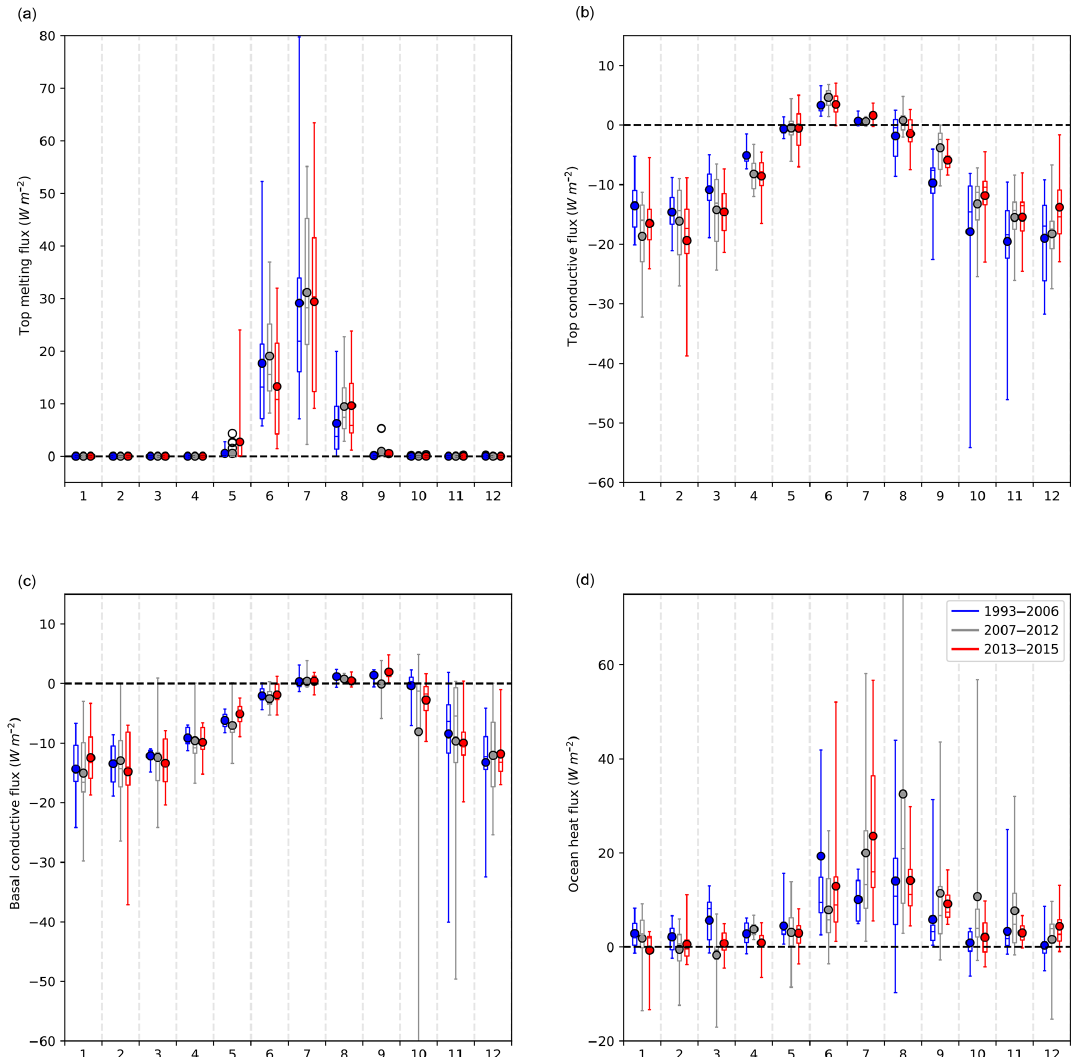
Figure 8. IMB-measured distributions of (a) top melting; (b) top conductive flux; (c) basal conductive flux, and (d) ocean heat flux, divided into the three periods 1993–2006, 2007–2012, and 2013–2015. Each distribution is illustrated with a boxplot showing range, interquartile range, median (horizontal lines) and mean (filled